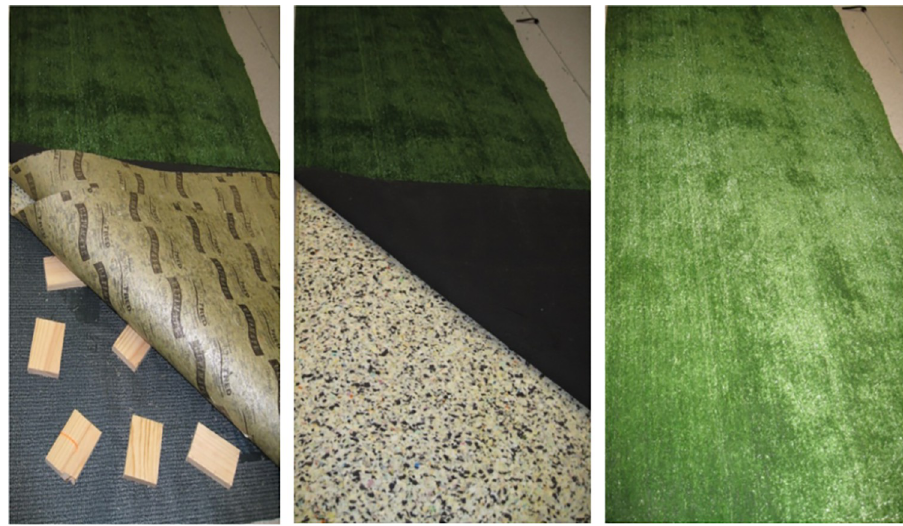
Fig 2. Uneven surface. This consisted of wooden blocks glued onto a mat (left) which were overlayed with foam (centre) and artificial grass (right).